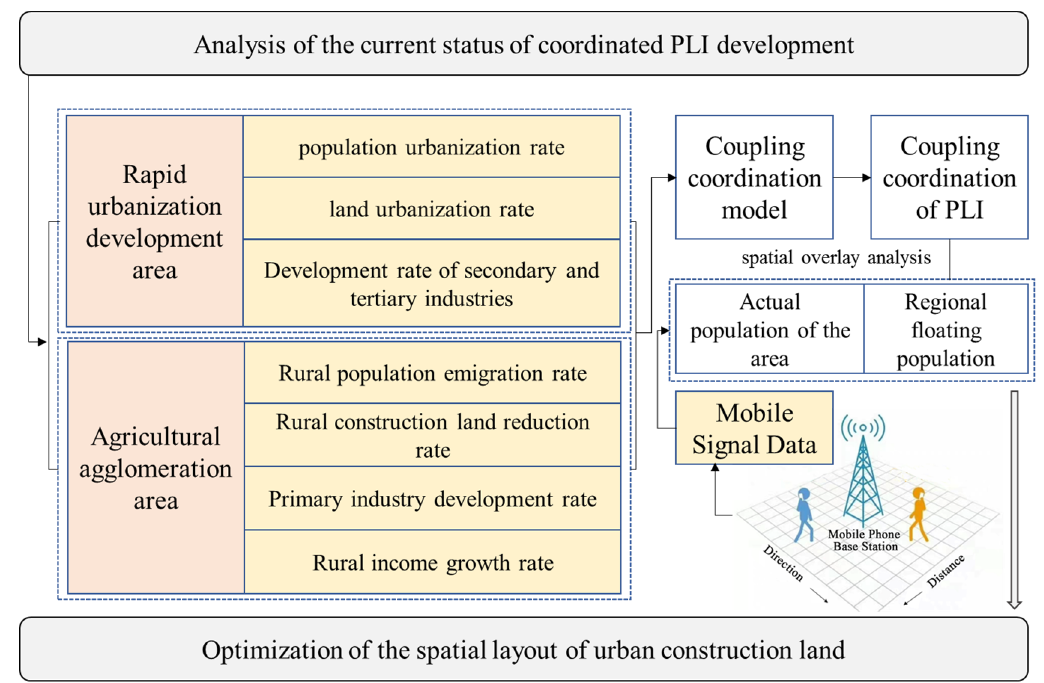
Figure 2. Research design and methods.